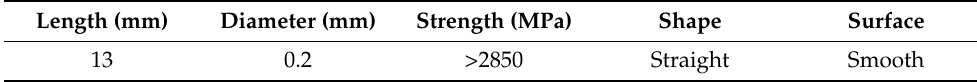
Table 2. Mix proportion of UHPC.